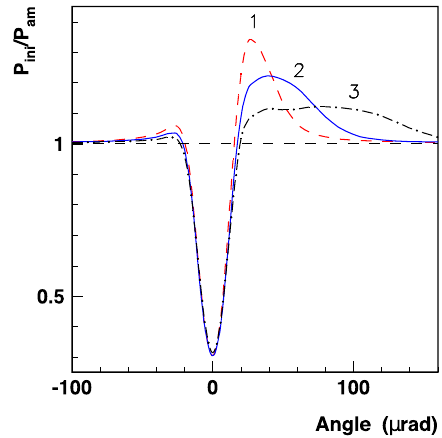
Fig. 5 The simulated INI rate for 180 GeV/c positive hadrons as a function of the orientation angle of two silicon crystals with the same bending radius but adifferent thicknessalongthebeamdirection. Curve 1 refers to a 2 mm thick crystal with a bending of 30 µ rad, curve 2 refers to a crystal 4 mm thick with a bending of 61 µ rad and curve 3 refers to a 8 mm thick crystal with a bending of 120 µ